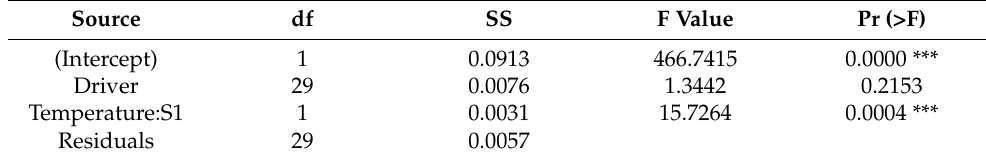
Table 6. ANOVA for regression model with temperature–scenario